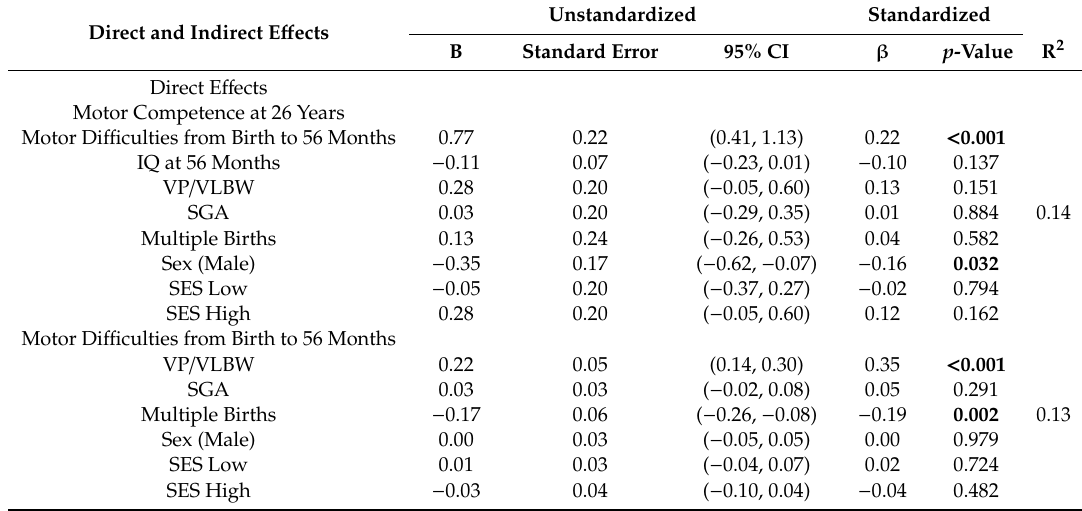
Table 2. Regression coefficients using structural equation modelling (Model 1).